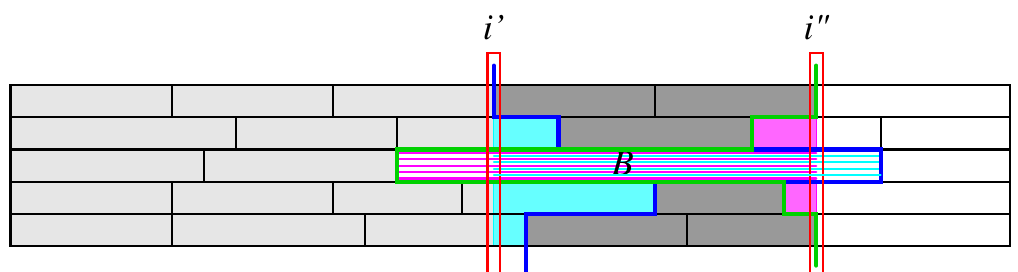
Figure 2. Definition of auxiliary variables. The input segments contributing to δ < ( i (cid:48)(cid:48) ) are all those to the left of the green ( i (cid:48) ) are to the left of the blue line, i.e, those shown in light gray. The large line (i.e., the ones shown in light and dark gray. δ ≤ ( i (cid:48) ) but not in δ < ( i (cid:48)(cid:48) ) . The correction terms δ ∩ > ( i (cid:48) ) and δ ∩ < ( i (cid:48)(cid:48) ) comprise the cyan and magenta interval B is included in δ ≤ parts, respectively. The correction term δ ∗ ( i (cid:48) , i (cid:48)(cid:48) ) , finally adds takes care of the interval B